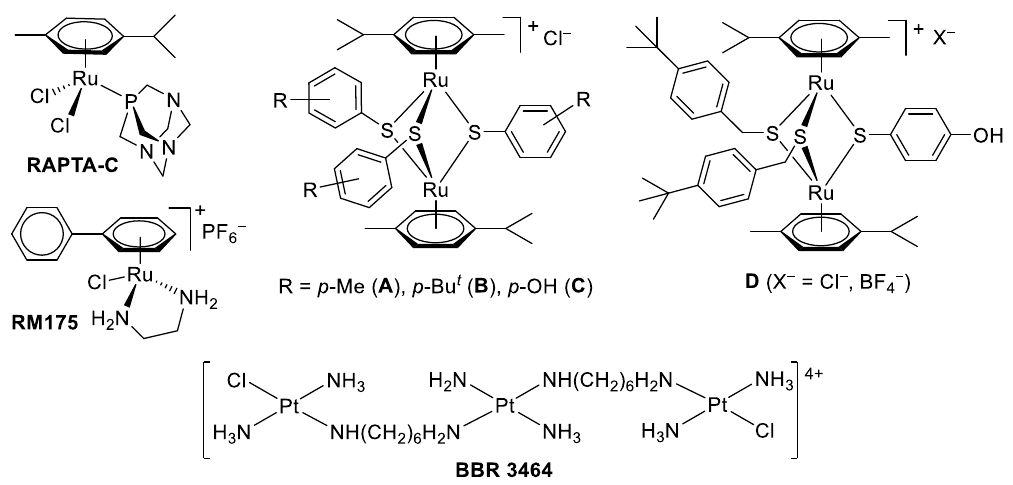
Figure 1. Structures of the ruthenium(II)-arene complexes RAPTA-C and RM175 , of selected symmetric and mixed trithiolato-bridged ruthenium(II)-arene complexes, and of the trinuclear platinum compound BBR 3464